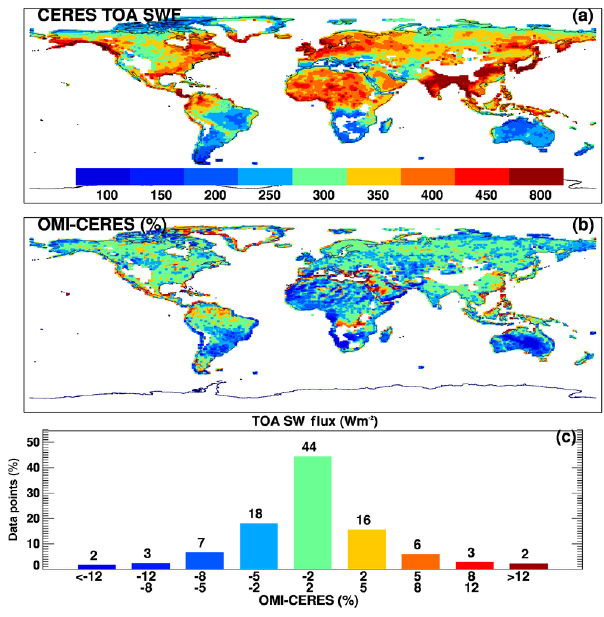
Figure 13. Similar to Fig. 10a, c, and d except over land for July 2007.